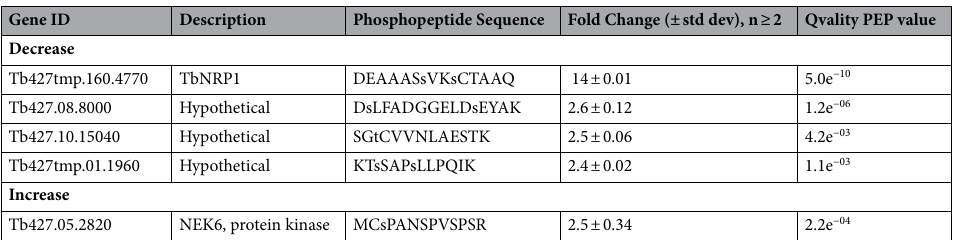
Table 2. Proteins affected by both treatment of trypanosomes with AEE788 and knockdown of TbNRP1. Proteins shown in the table are TbNRP1-pathway proteins that were also affected by treatment of trypanosomes with AEE788 for 9 h. AEE788 data used to prepare the table was obtained from Sullenberger et al.,